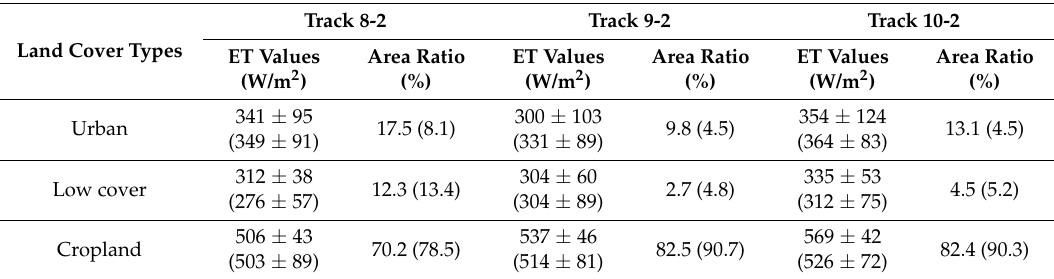
Table 2. ET values (mean ± standard devariation) and area ratio of each dominant land cover type in the WiDAS and ASTER images. The values in the parentheses represent the values derived from the ASTER